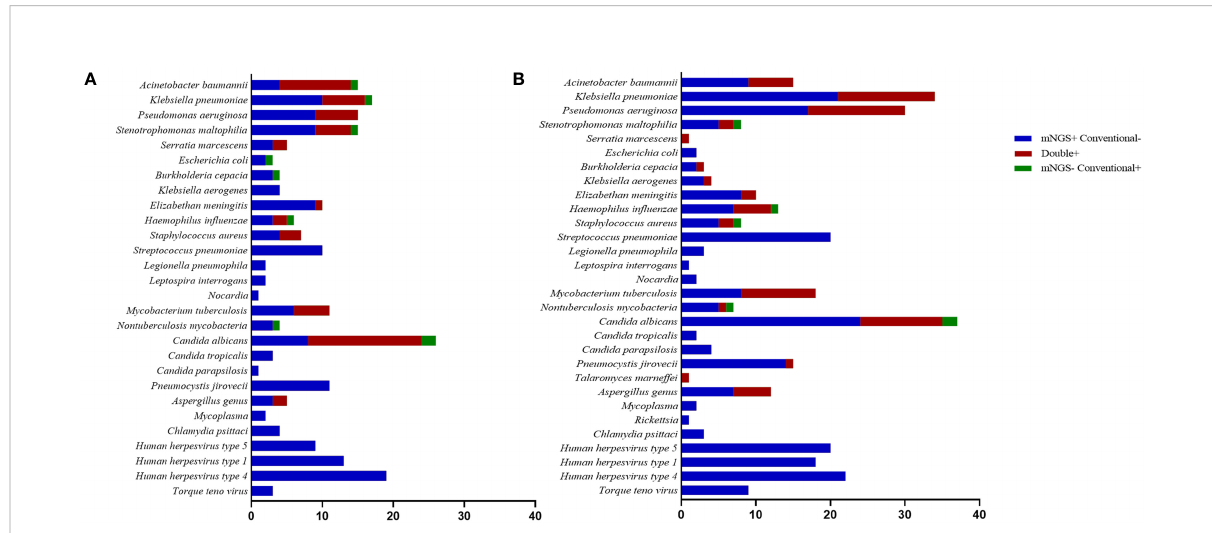
FIGURE 2 Species distribution of bacteria, fungi, and other pathogens detected using metagenomic next-generation sequencing (mNGS) and conventional tests. (A) Commercial group. (B) In-house group.